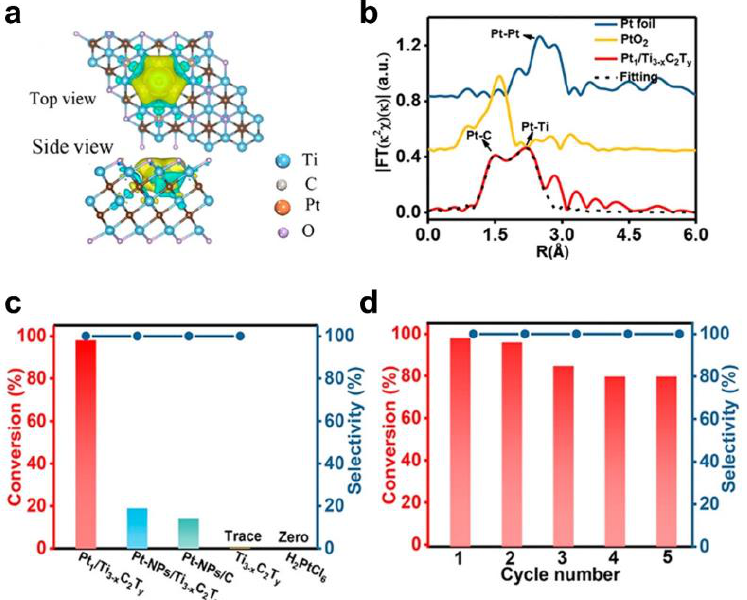
Figure 7. Identification of active sites and catalytic performance of MXene − based catalysts. ( a ) Charge density difference of Pt 1 /Ti 3−x C 2 T y with a plain view (upper image) and a side − on view (lower image); ( b ) EXAFS FT k 2 −weighted χ(k) function spectra of Pt 1 /Ti 3−x C 2 T y and a reference; ( c ) Catalytic performance of the N − formylation of aniline using different catalysts; ( d ) Recycling test of Pt 1 /Ti 3−x C 2 T y for the catalytic N − formylation of aniline. (Reprinted with permission from Ref. [81]. Copyright 2019 American Chemical Society).